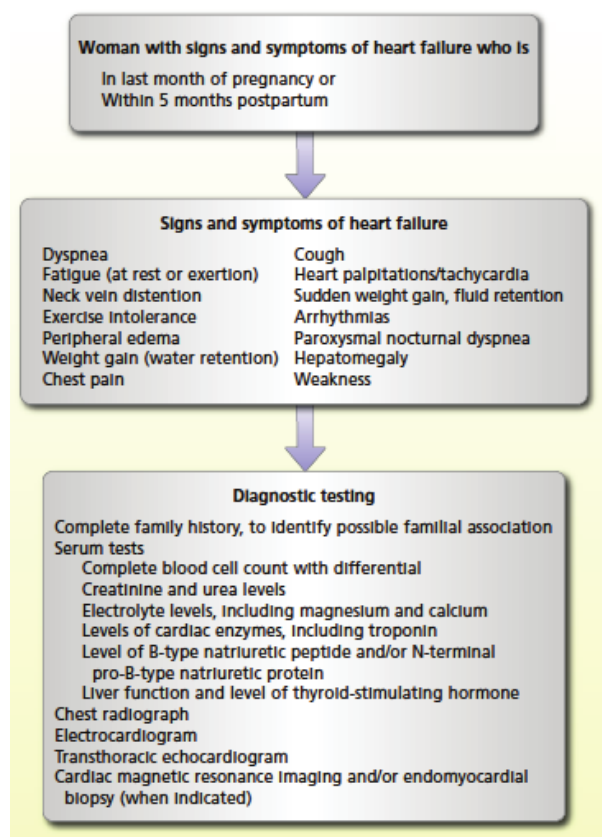
Figure 2. Evaluation of PPCM